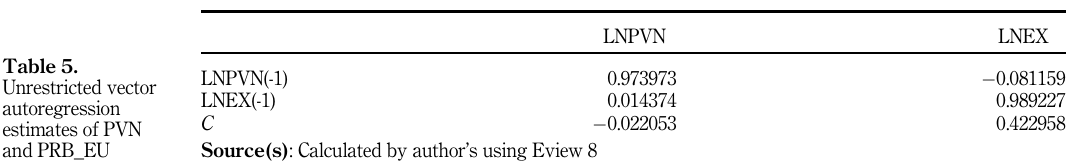
Table 4. Cointegration rank test